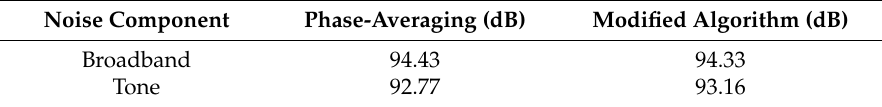
Table 1. Integrated tone and broadband spectral levels for the model turbofan.